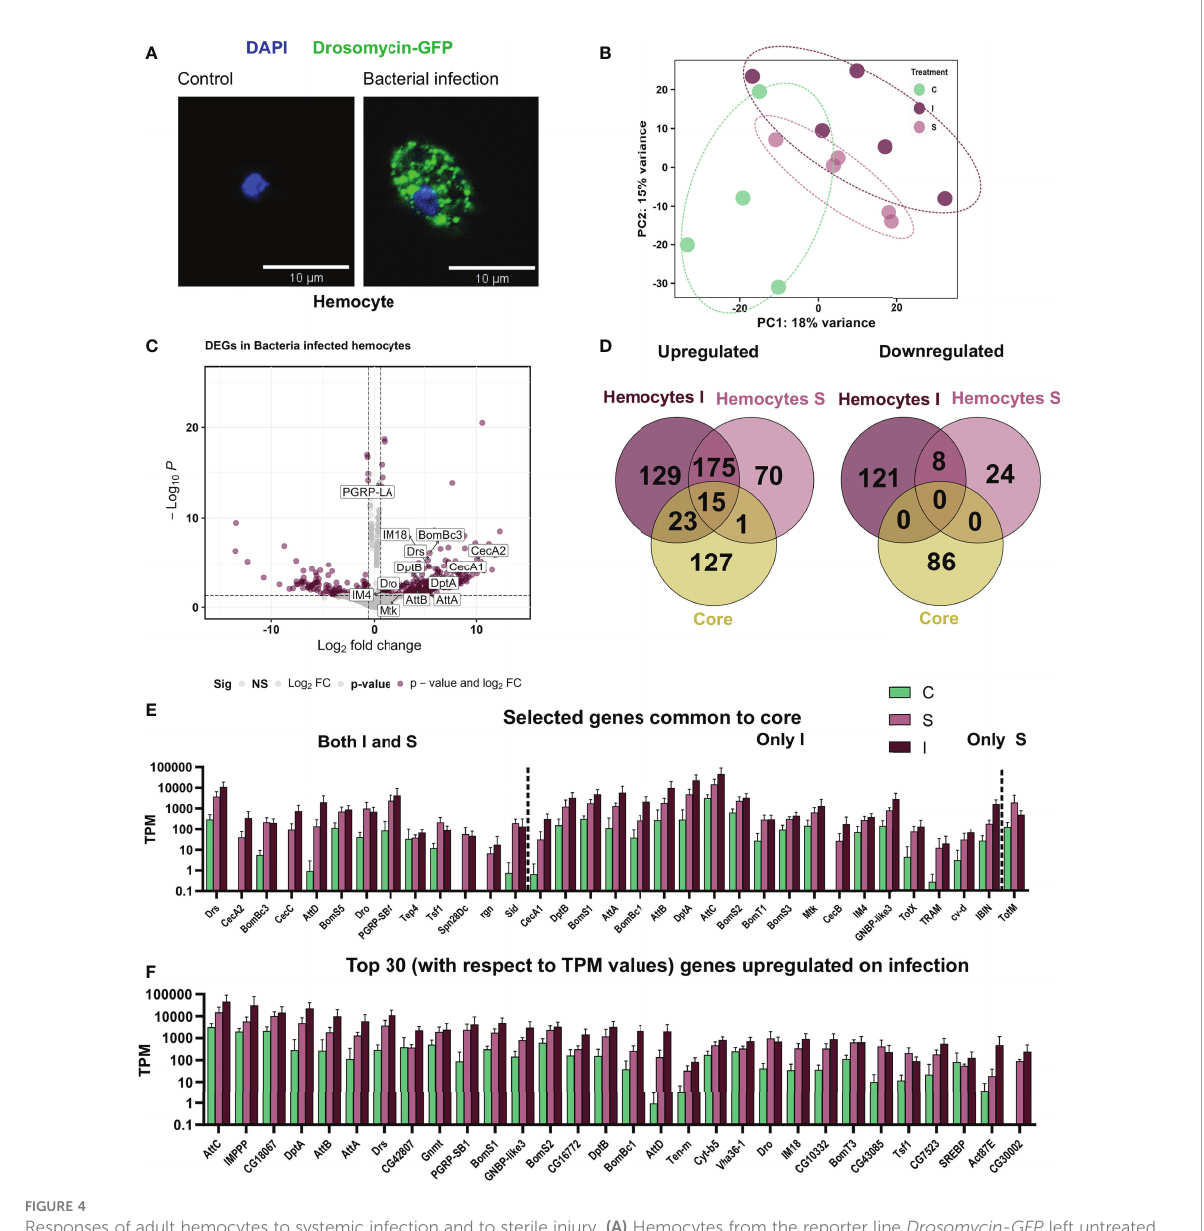
FIGURE 4 Responses of adult hemocytes to systemic infection and to sterile injury. (A) Hemocytes from the reporter line Drosomycin-GFP left untreated (left) and after infection with B. subtilis (right). The nuclei are stained with DAPI. (B) Principal Component Analysis plot showing the fi rst two principal components for the RNA-seq analysis of control (C), sterile injury(S), and bacteria infected (I) adult hemocytes. (C) Volcano plot depicting the differentially expressed genes in bacteria infected hemocytes as compared to untreated control hemocytes. The genes passing the threshold (adjusted p-value < 0.05 and log 2 fold change > 0.6) were considered differentially expressed and are marked in maroon and the rest of the genes are marked in gray. Some of the differentially expressed AMPs are labeled in the graph. (D) Venn diagram analysis of the common number of regulated genes in the bacteria infected (I) and sterile injury (S) hemocytes (each compared to untreated controls) and the ‘ core ’ genes from the whole body are shown separately for the upregulated and downregulated genes. (E) Transcript per Million (TPM) values are shown for selected genes that were commonly regulated between the full body ‘ core ’ dataset and the bacteria infected (I) and sterile injury (S) hemocyte data sets. (F) TPM values are shown for the top 30 upregulated genes, i.e., the DEGs with the highest abundance values in terms of read counts, in bacteria infected